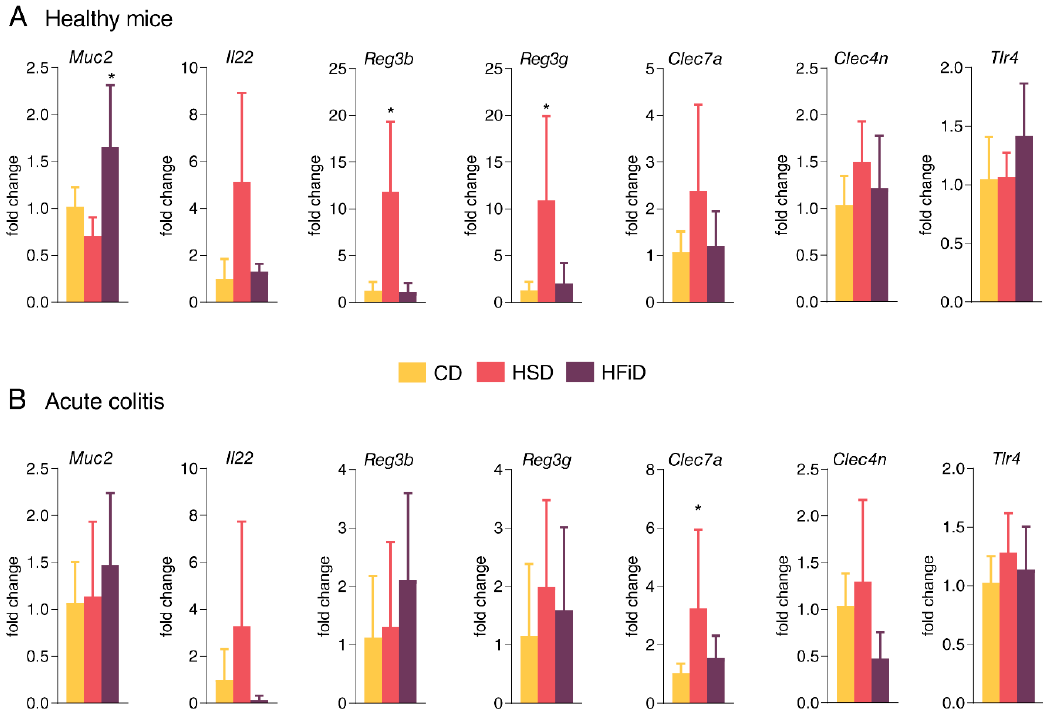
Figure 5. Colonic mRNA expression of genes related to gut barrier was changed. ( A ) HSD significantly influenced mRNA expression of antimicrobial peptides Reg3b, Reg3g , and Il22 (not significant) and slightly influenced mRNA expression of pattern recognition receptor dectin 1 ( Clec7a ). ( B ) DSS-induced acute colitis had partial influence on Reg3b and Reg3g mRNA expression, but all other measured genes showed a similar trend as in healthy mice. Data presented are from one experiment out of three, n = 5–8 mice per group. Means significantly different from CD were calculated by one-way ANOVA with Dunnett’s multiple comparison test. Data are shown as mean ± SD. * p < 0.05. CD, control diet; HSD, diet rich in simple carbohydrates; HFiD, diet rich in fiber.